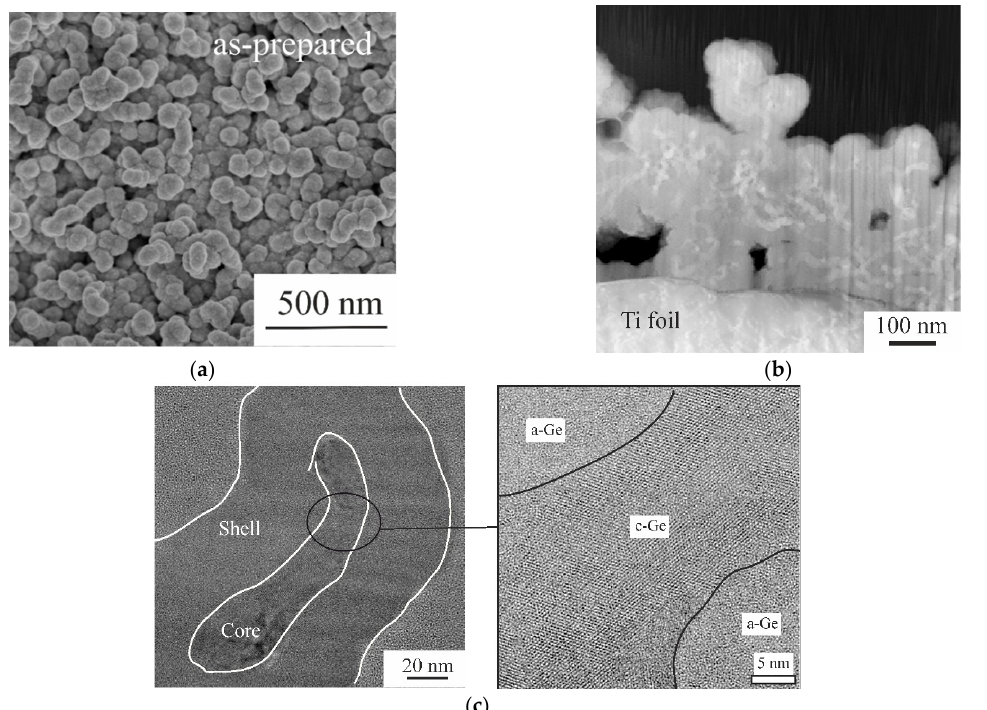
Figure 1 . ( a ) SEM image of the Ge microrods with a core–shell structure; ( b ) HAADF-STEM image of a cross section of the Ge microrods with a core–shell structure; ( c ) HRTEM image of a fragment of a cross section of a Ge microrod.